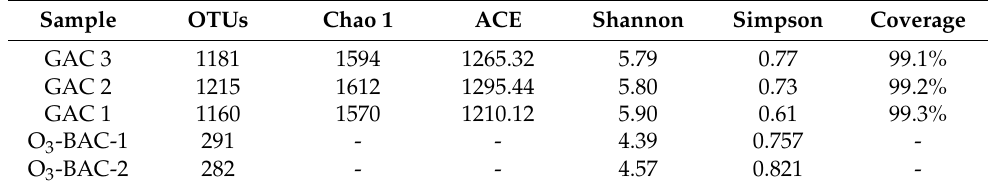
Table 5. Diversity estimators of microbial communities in GAC 1, GAC 2 and GAC 3 ( α =